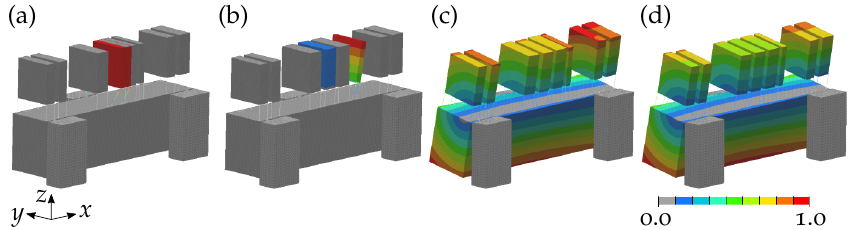
Figure 18. First mode shape of the magnet–girder assembly with the box girder depending on the connection stiffness between the magnets and the girder, i.e., different cross section diameters of the beams connecting the magnets to the girder involving 5 mm ( a ), 30 mm ( b ), 60 mm ( c ), and 100 mm ( d ). The colours represent the normalised vibration